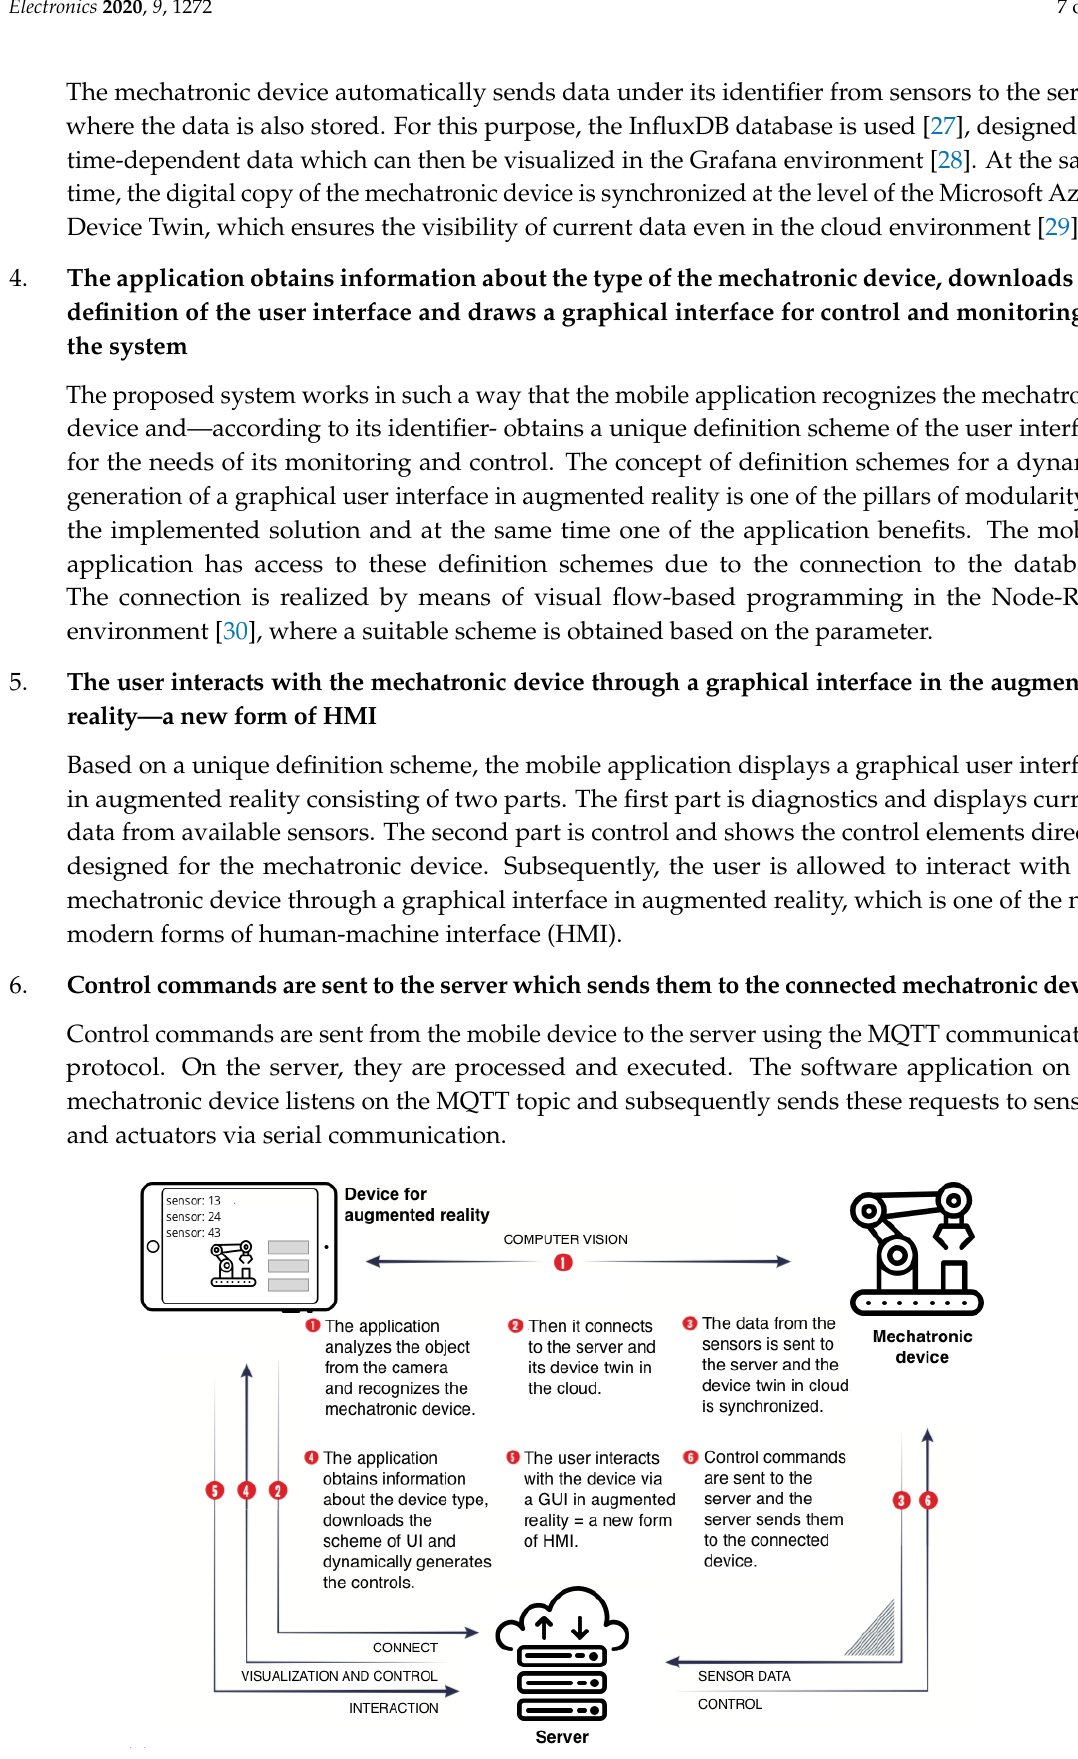
Figure 3. Proposal of mechatronic device monitoring and control using augmented